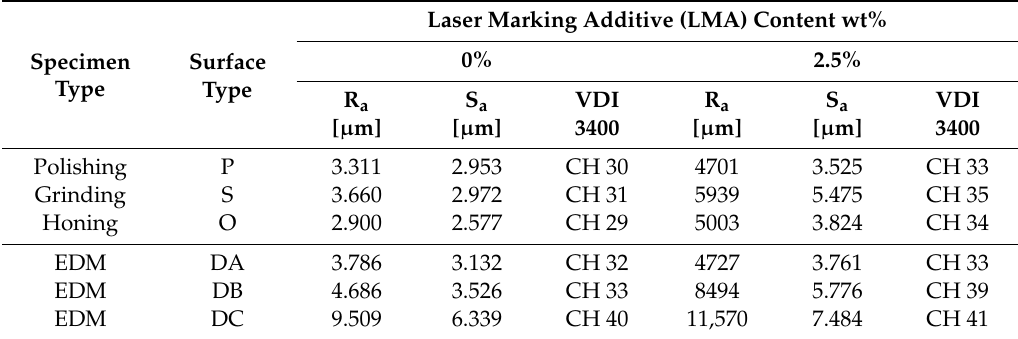
Table 6. Topography of PP samples after the laser beam